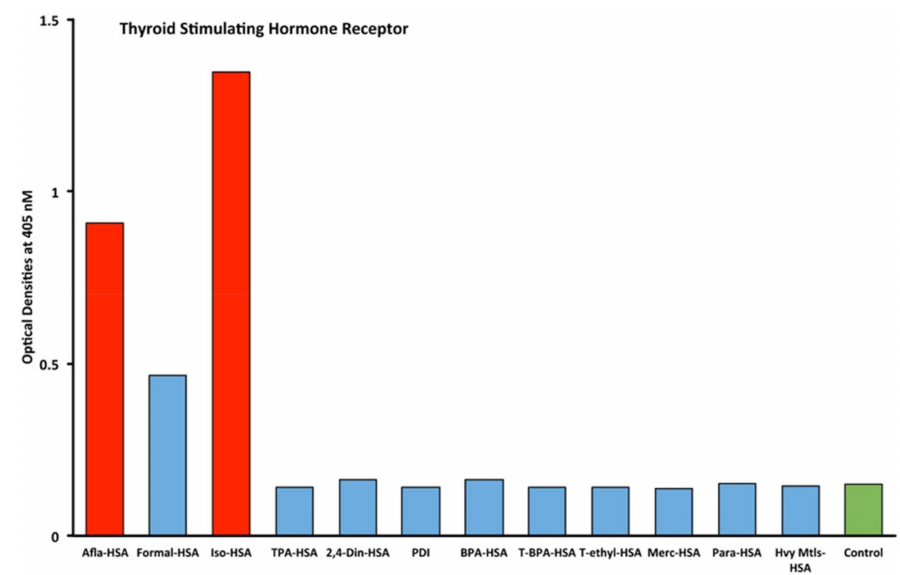
Figure 1. Reaction of thyroid-stimulating hormone receptor polyclonal antibodies with di ff erent chemicals bound to human serum albumin. The antigens in red represent optical density (OD) levels that are above the control and also 1 standard deviation above the mean of all 84 single measurements of chemicals bound to human serum albumin (HSA). The antigens in blue are less than 1 standard deviation above the mean. The control is in green. Afla-HSA = aflatoxin-HSA; Formal-HSA = formaldehyde-HSA; Iso-HSA = isocyanates-HSA; TPA-HSA = trimellitic + phthalic anhydride-HSA; 2,4-Din-HSA = 2,4-dinitrophenol-HSA; PDI = protein disulfide isomerase; BPA-HSA = bisphenol-A-HSA; T-BPA-HSA = tetrabromobisphenol-A-HSA; T-ethyl-HSA = tetrachloroethylene-HSA; Merc-HSA = mercury-HSA;